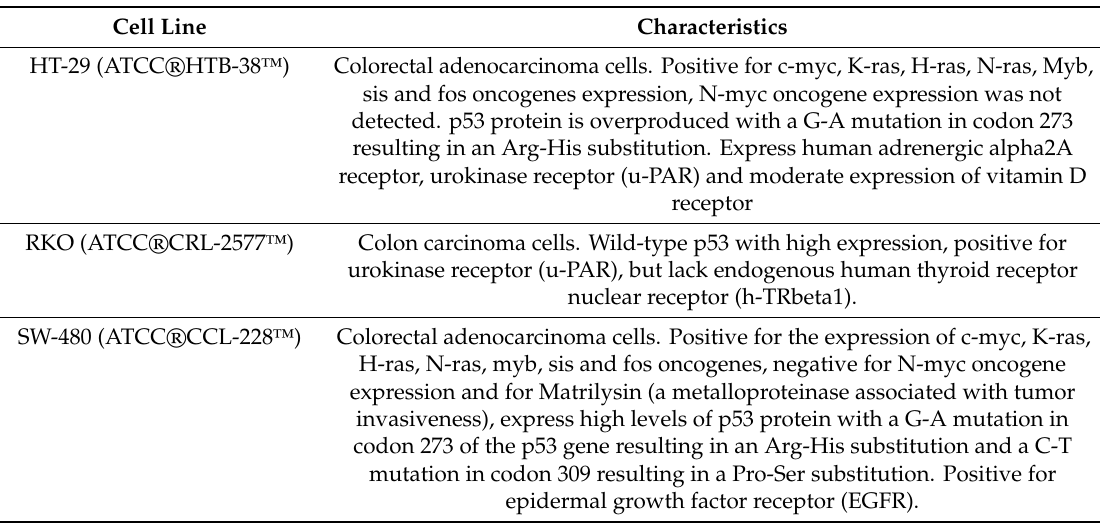
Table 1. Studied colon cancer cell